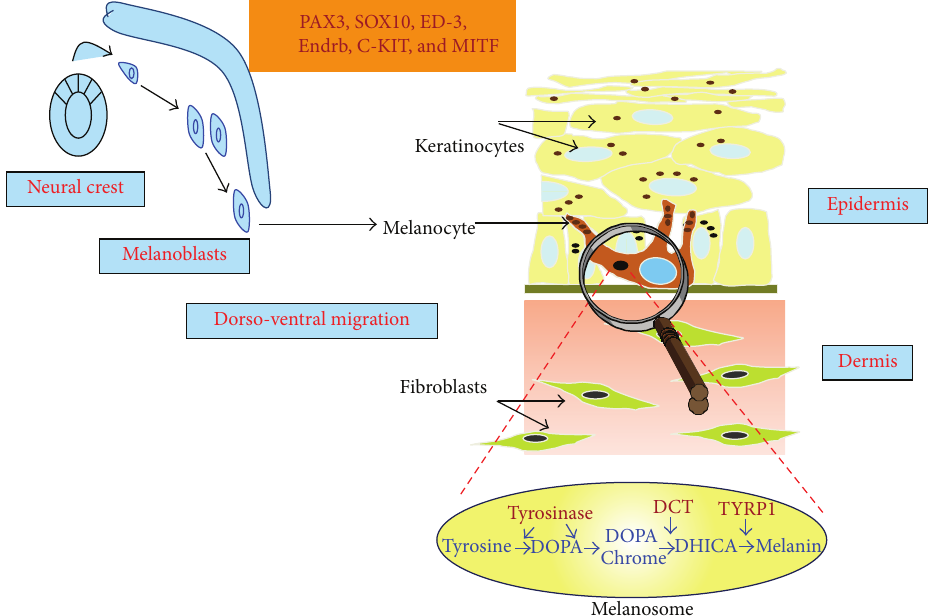
Figure 1: General overview of melanocyte physiology. Melanocytes derived from the neural crest in the form of undifferentiated and unpigmented precursors, the melanoblasts, migrate to their final destination, the epidermis, where they synthesize melanin in melanosomes. Pax3, Sox10, endothelin3 (ED-3) and its receptor (Endrb), c-Kit and Mitf play a critical role in the development of melanocytes. Melanin is then transferred to neighboring keratinocytes to ensure skin protection against the deleterious effect of ultraviolet